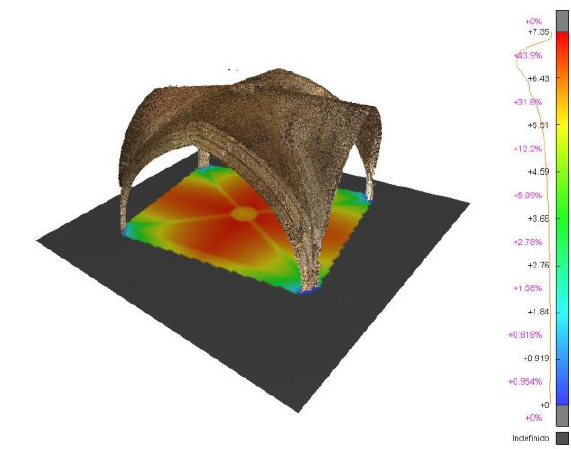
Figure 5. Example of comparison between the point cloud of a vault and the corresponding reference plane.